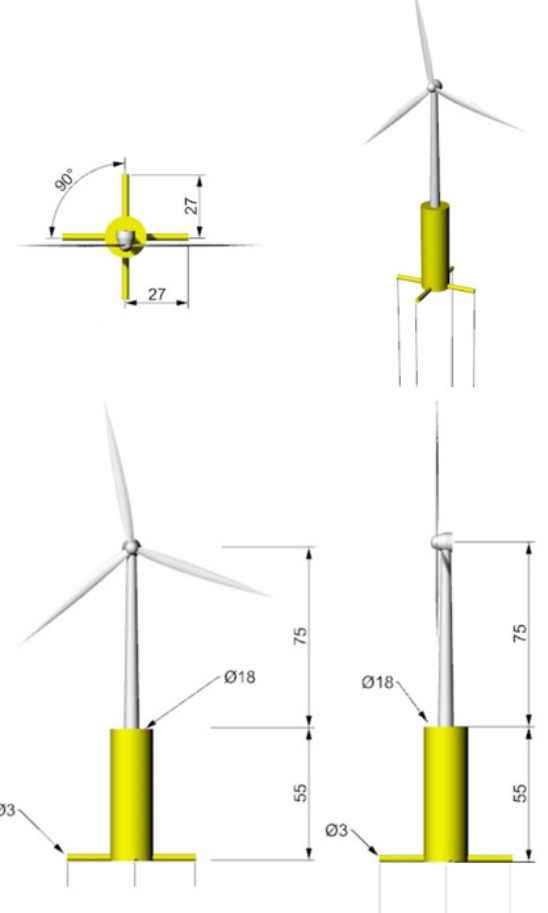
Figure 2. The schematic diagrams of the NREL 5MW wind turbine mounted on the MIT/NREL TLP with the taut-leg mooring system in different views. (Unit: m.)